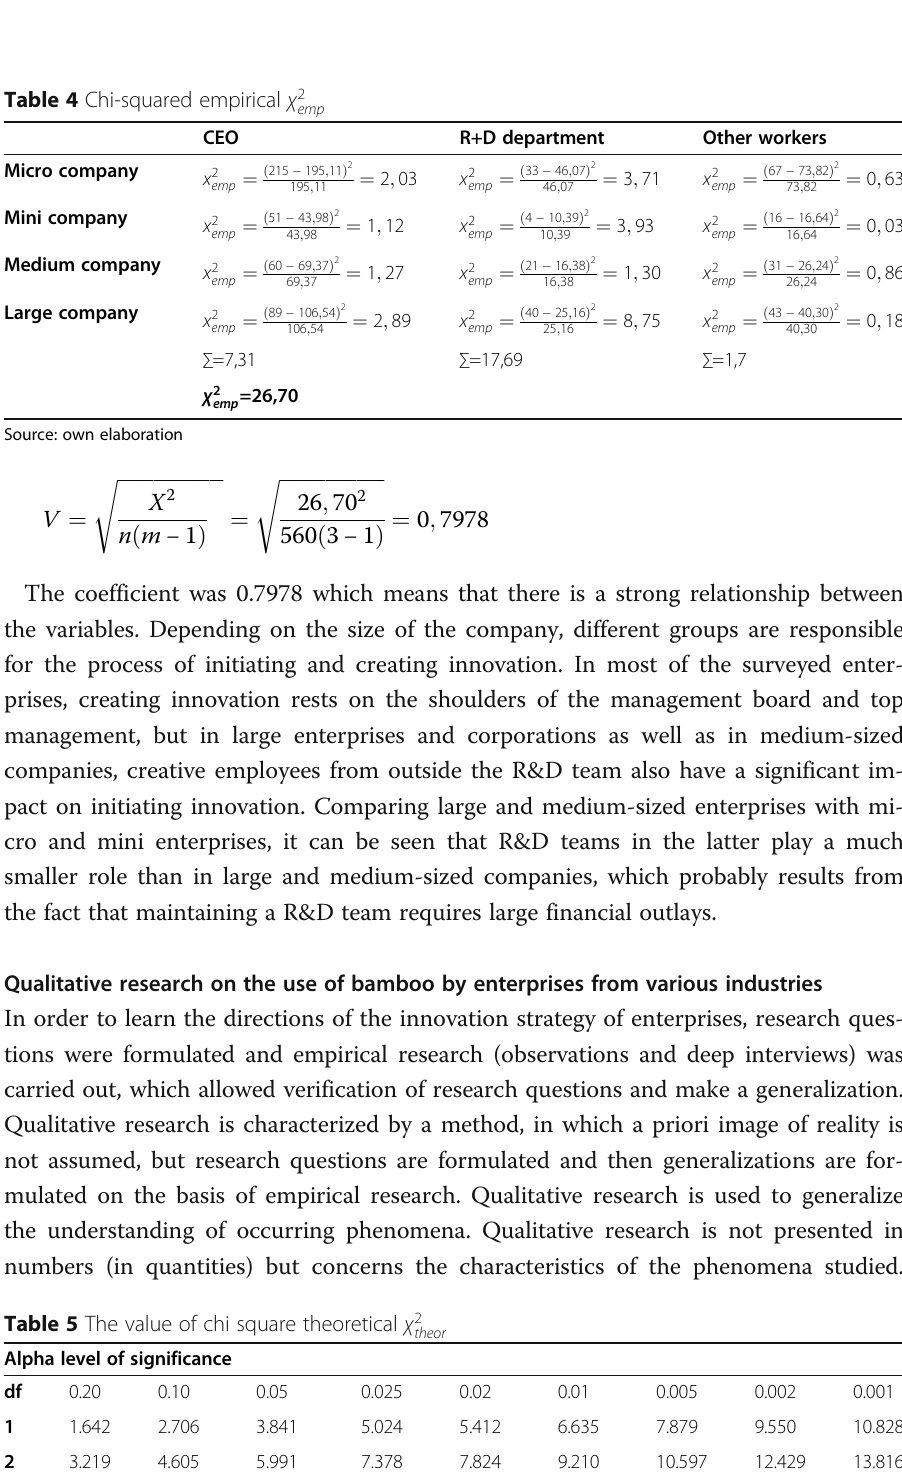
Table 5 The value of chi square theoretical χ 2 Alpha level of